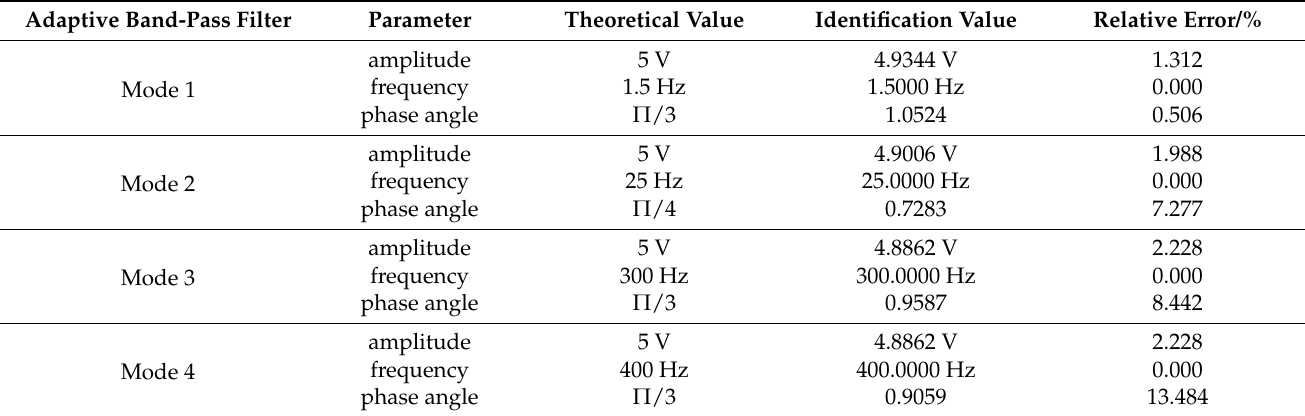
Table 2. Precision test results of each parameter.